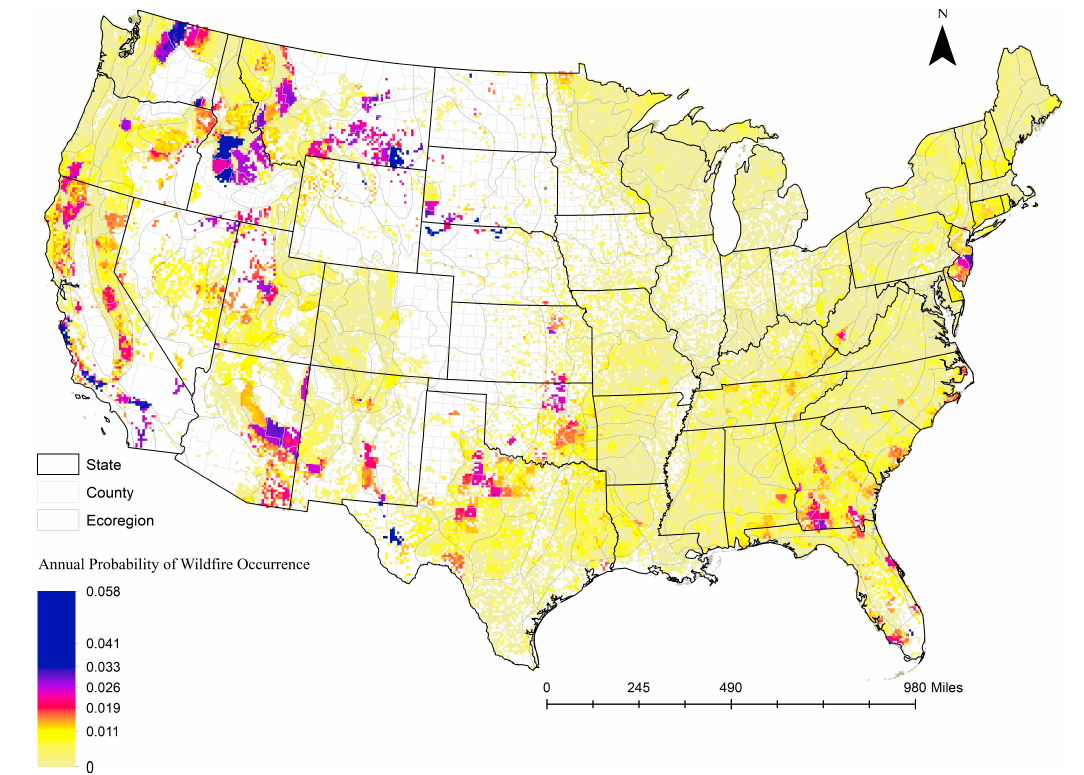
Figure 4. Annual probability of wildfire occurrences in FIA forest plots estimated using the fire risk equation across the continental United States. (Raster map download link: https://www.canr.msu.edu/socioeconomics/econ/data, accessed on 13 November 2022) .